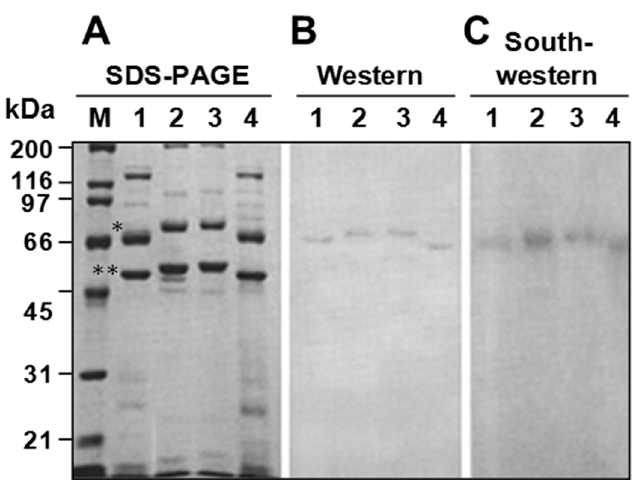
Figure 5. Ascovirus SfAV-1a P64 homologues are the only major virion proteins that bind DNA. ( A ) SDS-PAGE profiles of virion proteins of SfAV-1a (lane 1), Heliothis virescens AV-3a (lane 2), Trichoplusia ni AV-6a (lane 3), and Spodoptera exigua AV-7a (lane 4) probed with an anti-P64 antibody ( B ), or labeled dsDNA ( C ). The most abundant virion proteins are the P64 homologs (*) and the major capsid protein, MCP (**). M, molecular mass standards; kDa, kilodaltons.